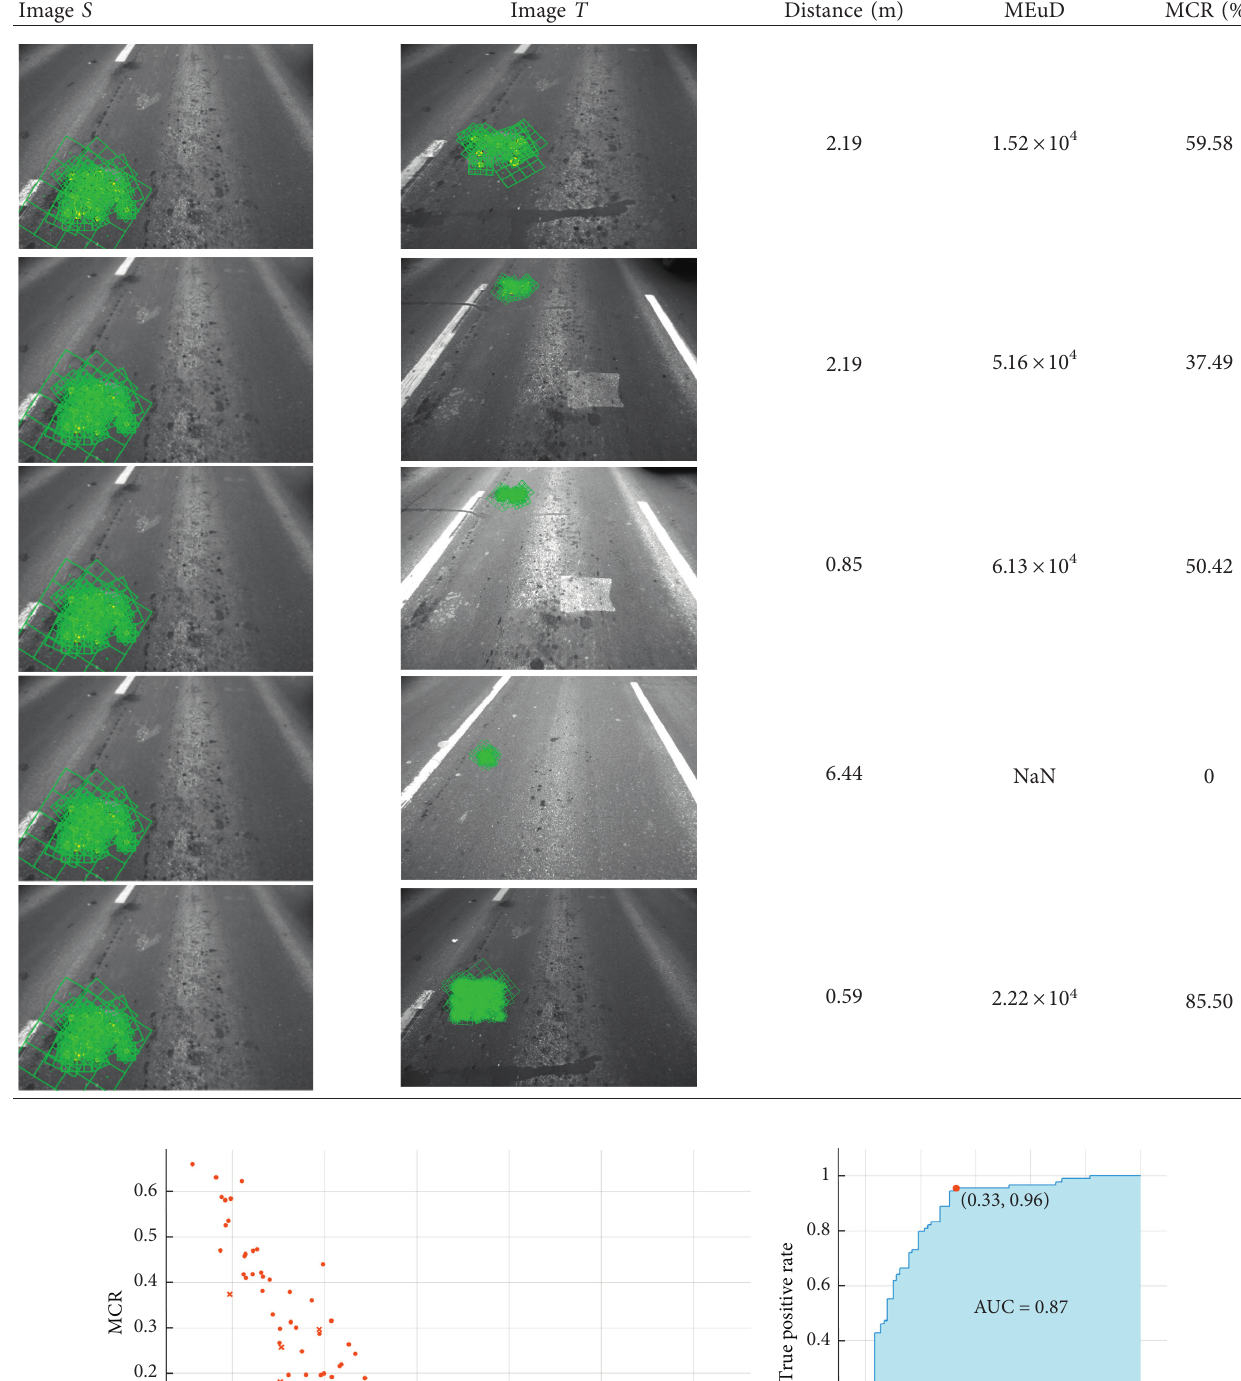
Table 1: SIFT matching results of the example images filtered by the specified GPS.